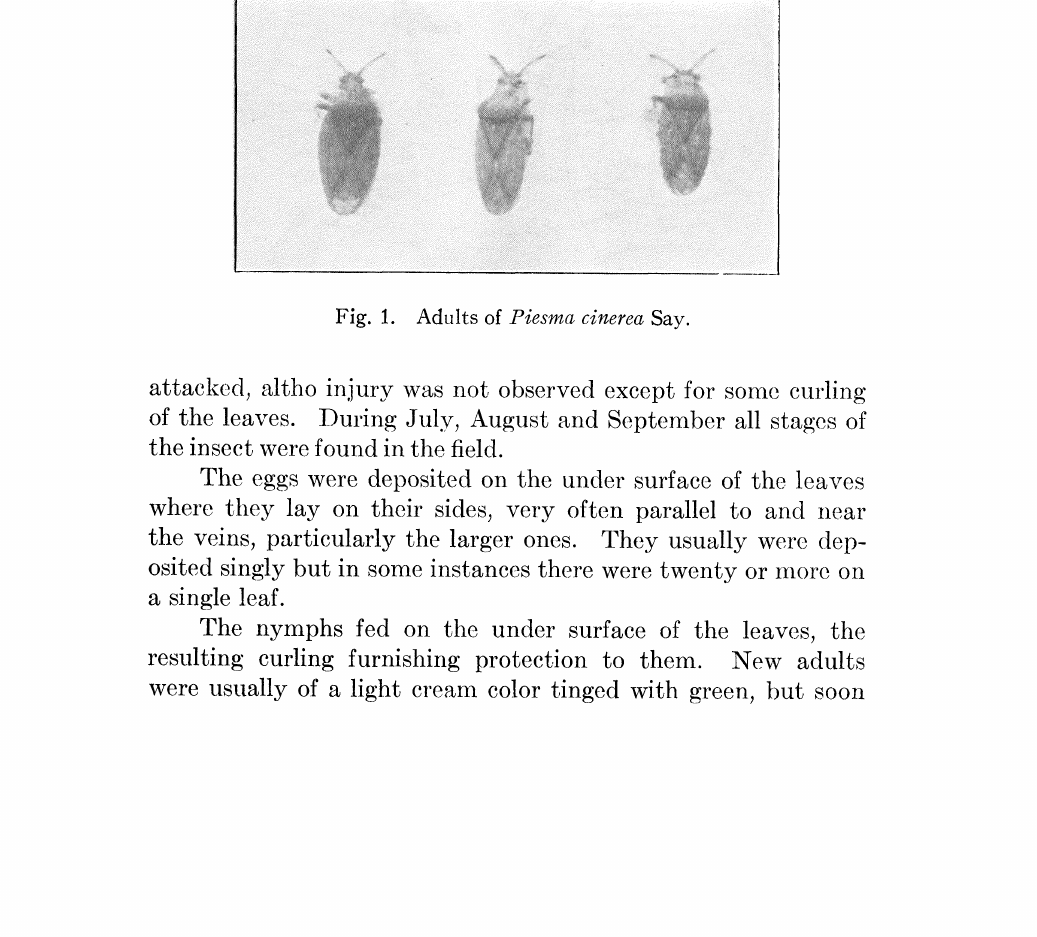
Fig. 1. Adults of Piesma cinerea